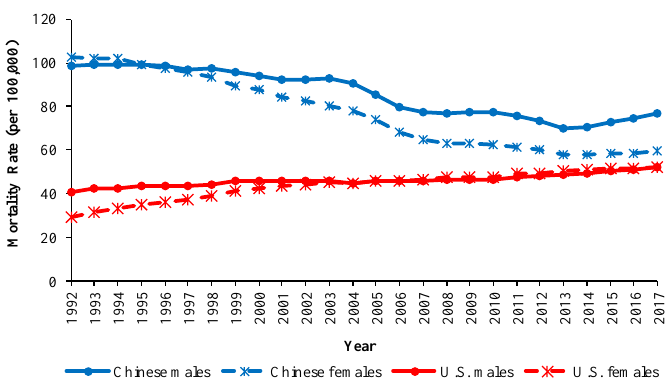
Figure 1. Trends in crude mortality rates (CMRs) from chronic obstructive pulmonary disease (COPD) by sex in China and the U.S., 1992 to 2017.